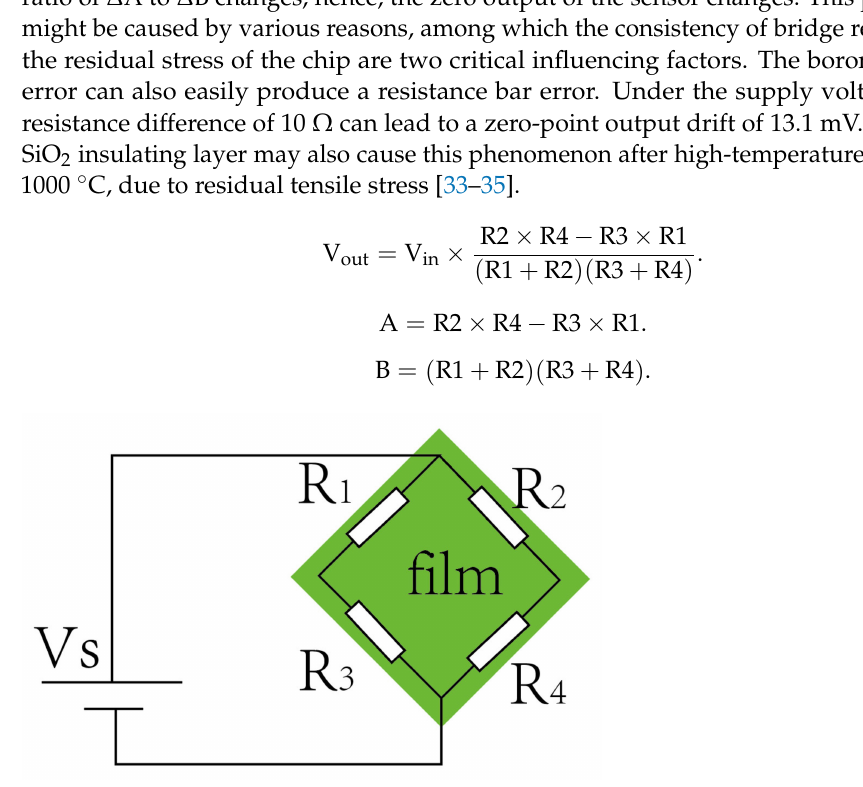
Figure 11. Schematic diagram of the Wheatstone bridge